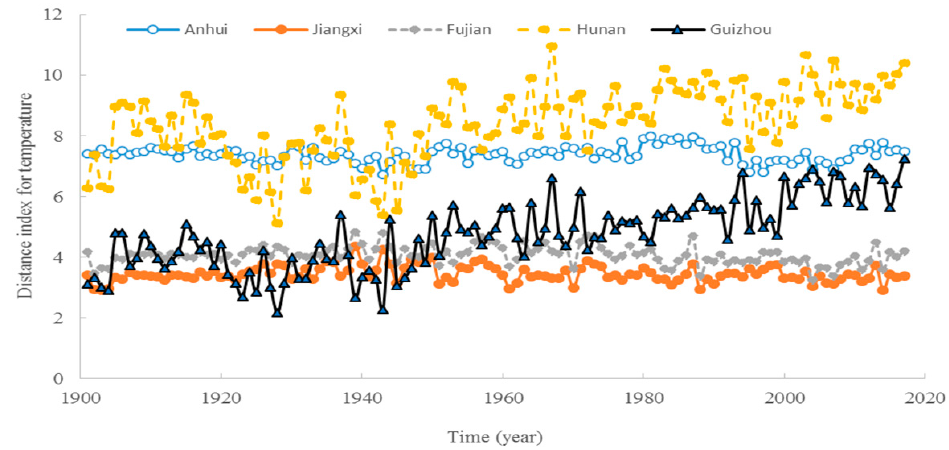
Figure 3. The Climate Distance Index (CDI) for air temperature between Zhuji and other regions (Anhui, Jiangxi, Fujian, Hunan, and Guizhou) from China (adapted from [7]). Yatagai et al. [8] evaluated extreme events and end-of-the-day (EOD) judgment based on Asian Precipitation Highly Resolved Observational Data Integration Towards Evaluation of Extreme Events (APHRODITE-2) . APHRODITE-2 ensures the informatively in the daily accumulation period (end of the day, EOD) over a specific domain. EOD products use reanalysis precipitation products CMORPH V1.0 and ERA-Interim. With this method, we can judge EOD precipitation over a station against unknown observation time.